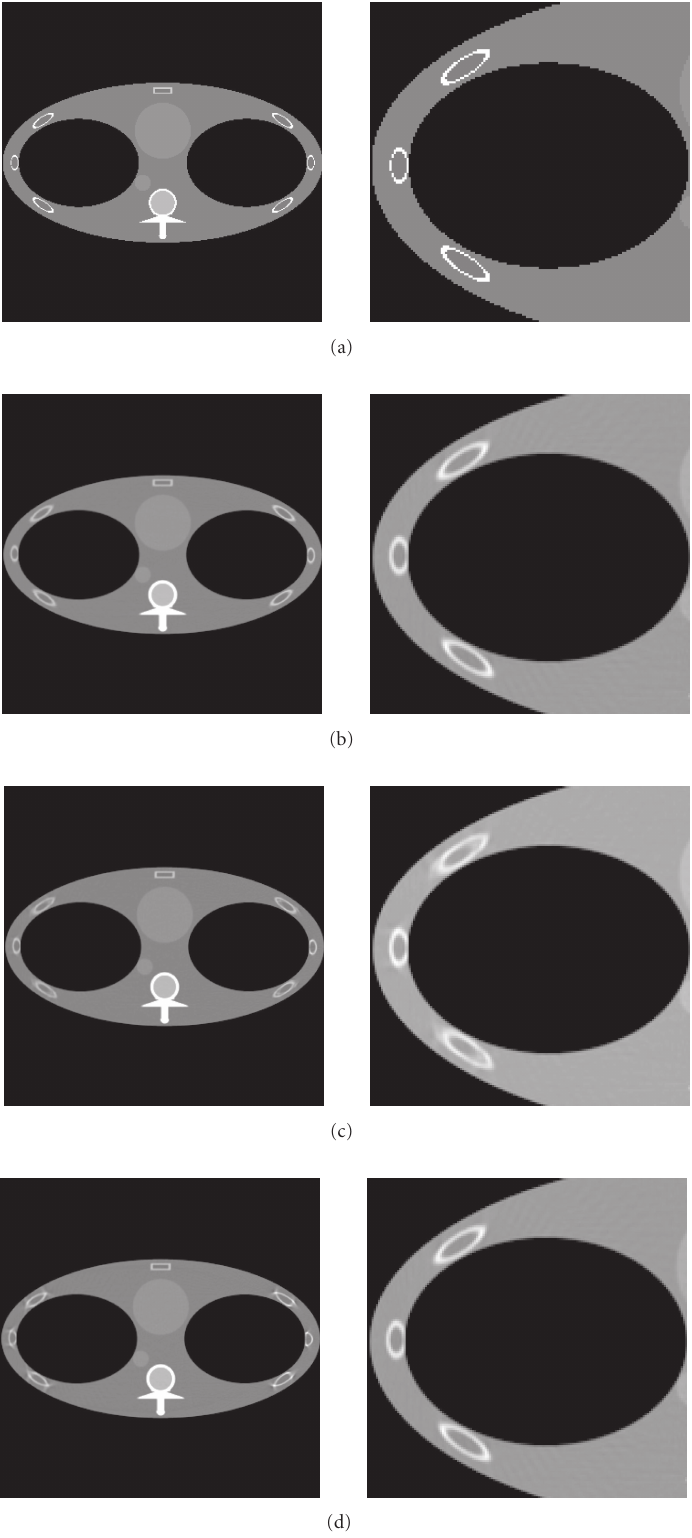
Figure 6: Images for the plane z = 0mm of thorax phantom generated with the proposed algorithm, gantry-tilted FDK algorithm, and gantry-tilted ASSR algorithm with M = 96